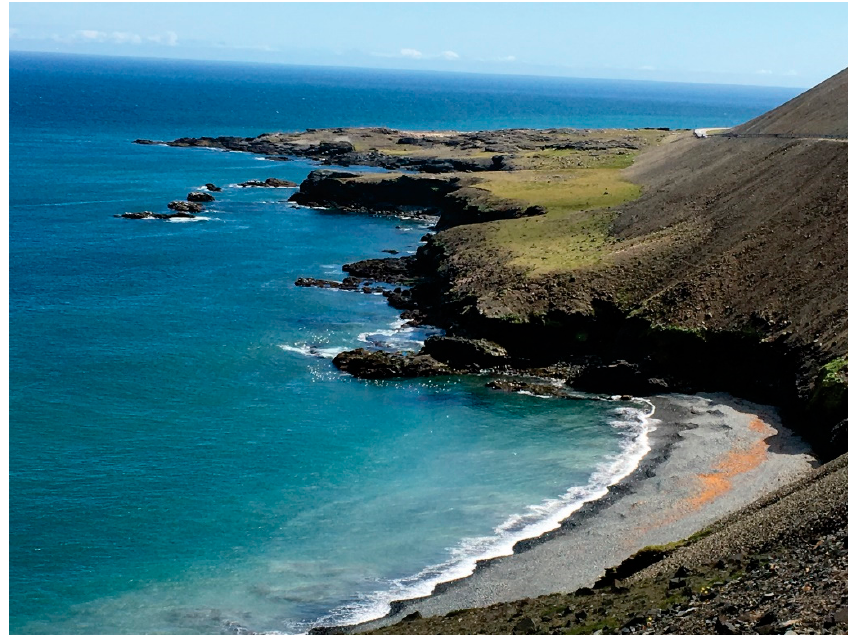
Figure 5. Crenulated coast with a bayhead beach in volcanic lavas, southeastern Iceland.